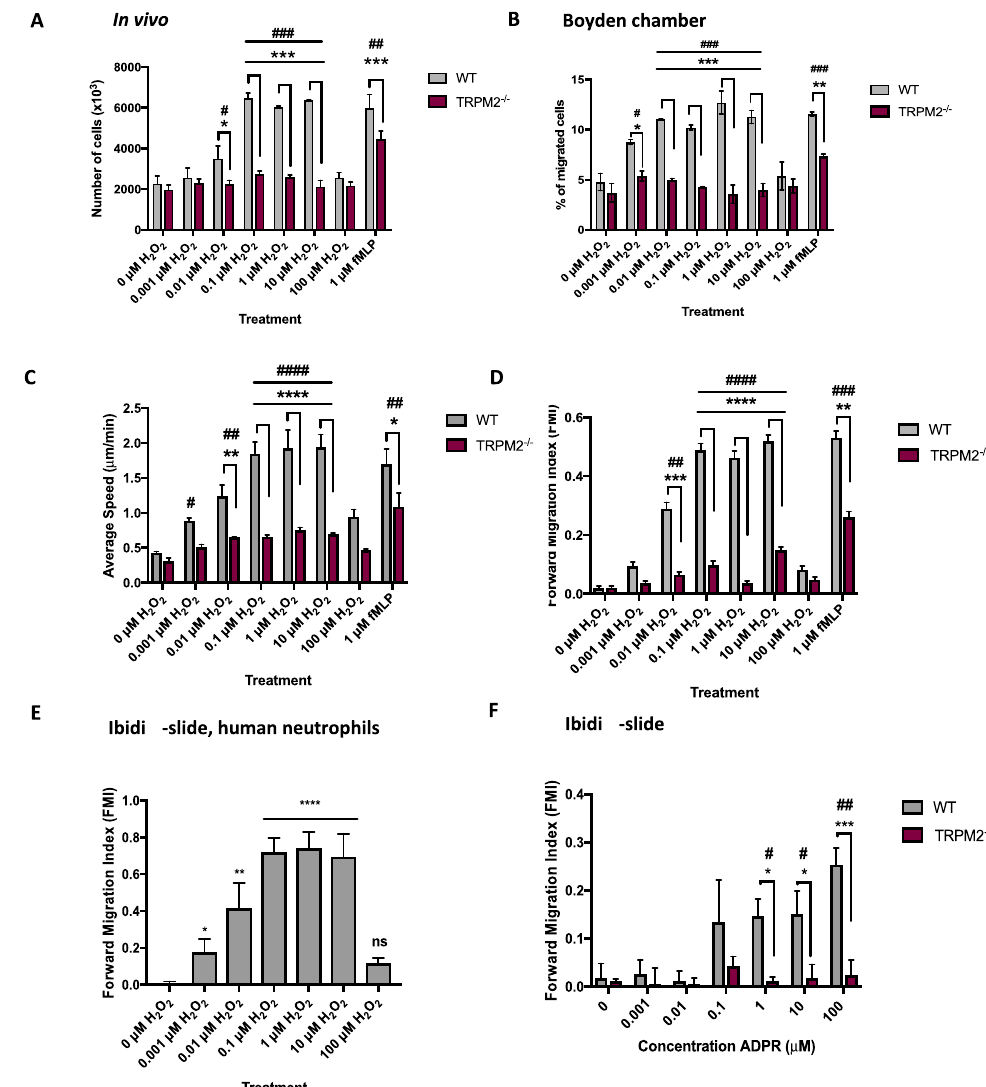
Figure 1. Neutrophil chemoattraction by H 2 O 2 depends on TRPM2. ( A ) Chemotaxis of neutrophils into the peritonea of WT and TRPM2 -/- mice following i.p. injection of H 2 O 2 . Direct injection of 0–100 μM H 2 O 2 or 1 μM fMLP into the peritonea of WT and TRPM2 −/− mice (see “Methods” section for details) elicited movement of total number of cells per peritoneum (ordinate). Time course of chemotaxis was determined in WT mice as shown in Supplementary Materials Fig. 1. Maximal chemotaxis in WT mice was calculated from the average of 3 points between 60 and 120 min. For TRPM2 −/− mice, chemotaxis was measured only at the 90 min point. Each bar shows mean ± SEM (n = 3 mice). ( B ) Boyden chamber assay of mouse neutrophil chemotaxis. Each bar shows mean ± SEM % migration from n = 4 mice (n = 8 for 0 µM H 2 O 2 ). ( C ) In vitro ibidi μ-slide chemotaxis chamber assay using mouse neutrophils. Average speed of neutrophil migration, calculated for each neutrophil as total path length of distance travelled divided by time. Each bar shows mean ± SEM of n = 4 mice. ( D ) In vitro ibidi μ-slide chemotaxis chamber assay using mouse neutrophils. Forward migration index (FMI) is distance migrated in direction of gradient of H 2 O 2 or fMLP divided by total distance travelled, from same experiments as shown in ( C ). Note that concentrations of H 2 O 2 in the nanomolar range are able to increase both speed and directionality of neutrophil migration, and that migration is inhibited at high concentrations of H 2 O 2 (> 10 μM). Distribution of values of FMI shown in Supplementary Materials Fig. 2. Each bar shows mean ± SEM of n = 4 mice. ( E ) In vitro ibidi μ-slide chemotaxis chamber assay using neutrophils isolated from human volunteer blood. FMI of human blood neutrophils shows similar dependence on concentration of H 2 O 2 to mouse peritoneal neutrophils (compare with D ). Each bar shows mean ± SEM of n = 3 individual human neutrophil samples. ( F ) Extracellular ADPR is a potent chemoattractant dependent on TRPM2 activation. WT mouse neutrophils showed significantly increased FMI compared to TRPM2 −/− neutrophils in response to 1–100 µM ADPR. Each bar shows mean ± SEM from n = 3 mice. Statistical analysis: For comparison with 0 H 2 O 2 : #, p < 0.05, ##, p < 0.01, ###, p < 0.001, ####, p < 0.0001 (One-way ANOVA and Tukey–Kramer post-hoc test). For comparison with TRPM2 −/− (except in E ): *, p < 0.05, **, p < 0.01, ***, p < 0.001, ****, p < 0.0001 (Two-way ANOVA and Bonferroni’s post-hoc